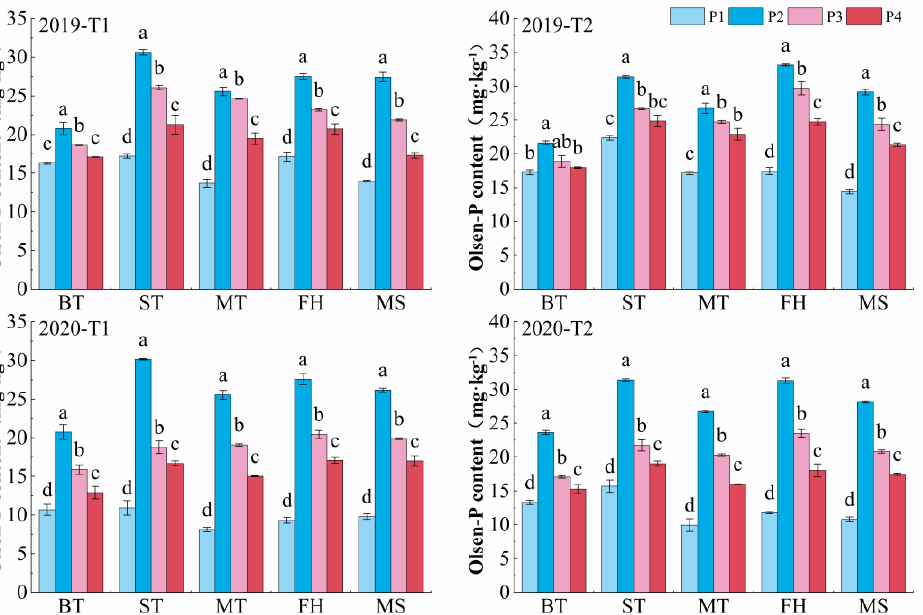
Figure 5. Soil Olsen-P content under different treatments in 2019 and 2020. Note: T1, no straw